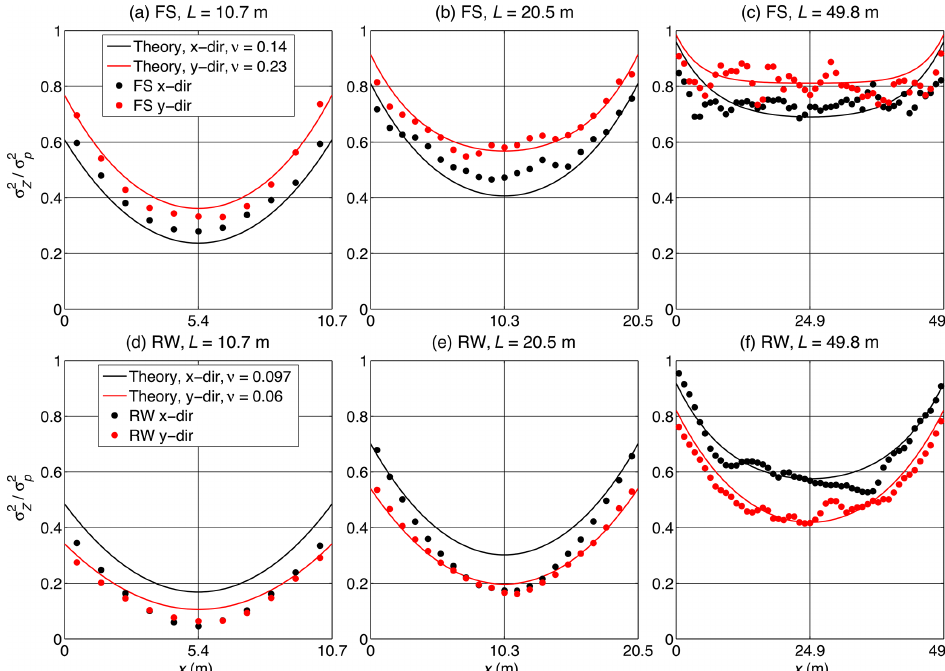
. σ 2 p ) for the case of a single measurement along a Z